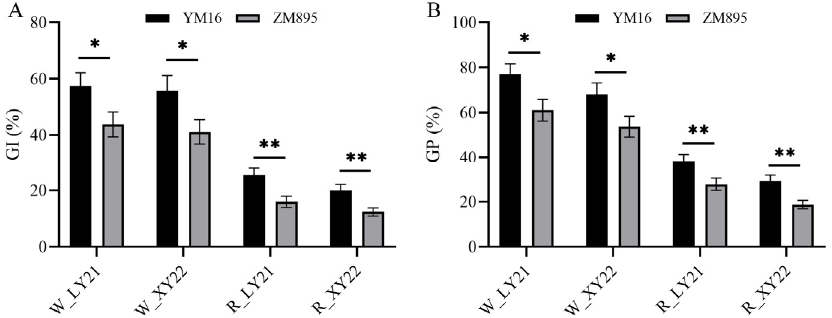
Figure 3. Effect of Qdor.hzau-3D.2 on GI ( A ) and GP ( B ) in red and white-grained DH subpopulations. The uppercase letter W and R on the x-axis represented white- and red-grained DH subpopula- tions; YM16 and ZM895 represented alleles of Qdor.hzau-3D.2 from Yangmai16 and Zhongmai895, respectively; * p < 0.05; ** p <